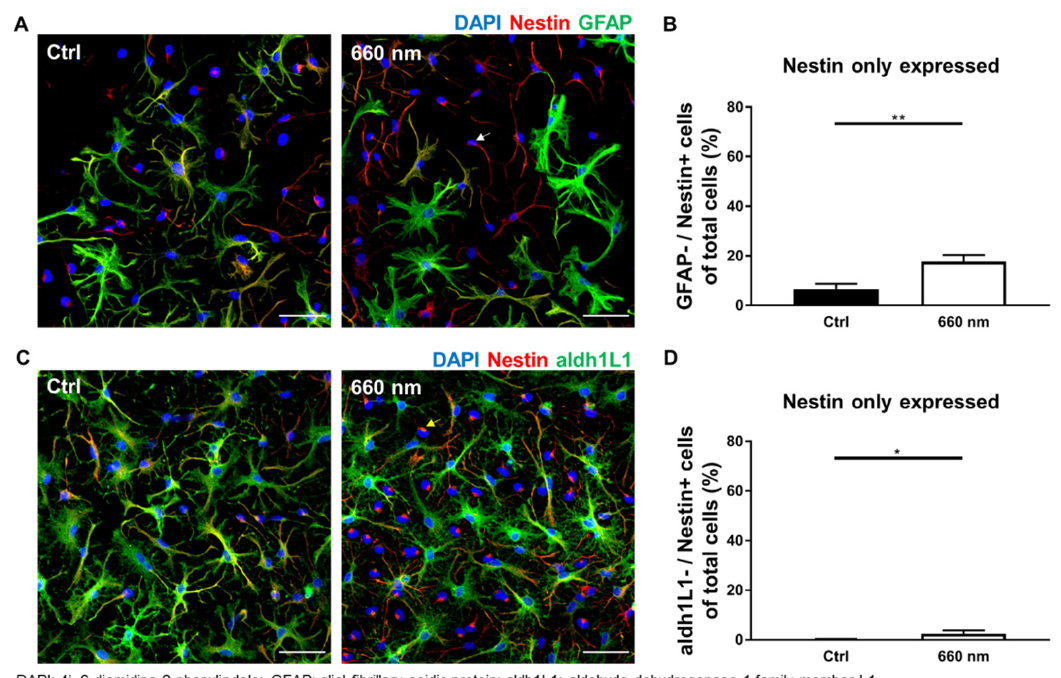
Figure 6. Astrocyte Differentiation Could be Altered by 660-nanometer LED Irradiation (nestin co-expression). ( A and C ) Representative images of immunofluorescence staining. The white and yellow arrow denotes nestin-expressing cells, which were significantly increased by 660-nanometer LED irradiation (scale bar: 50 μ m). ( B and D ) Only the graph of significant protein expression was shown. GFAP-/Nestin+ and aldh1L1-/Nestin+ expression levels were significantly increased compared to the control ( n = 38 and 39, * p < 0.05, ** p < 0.01).